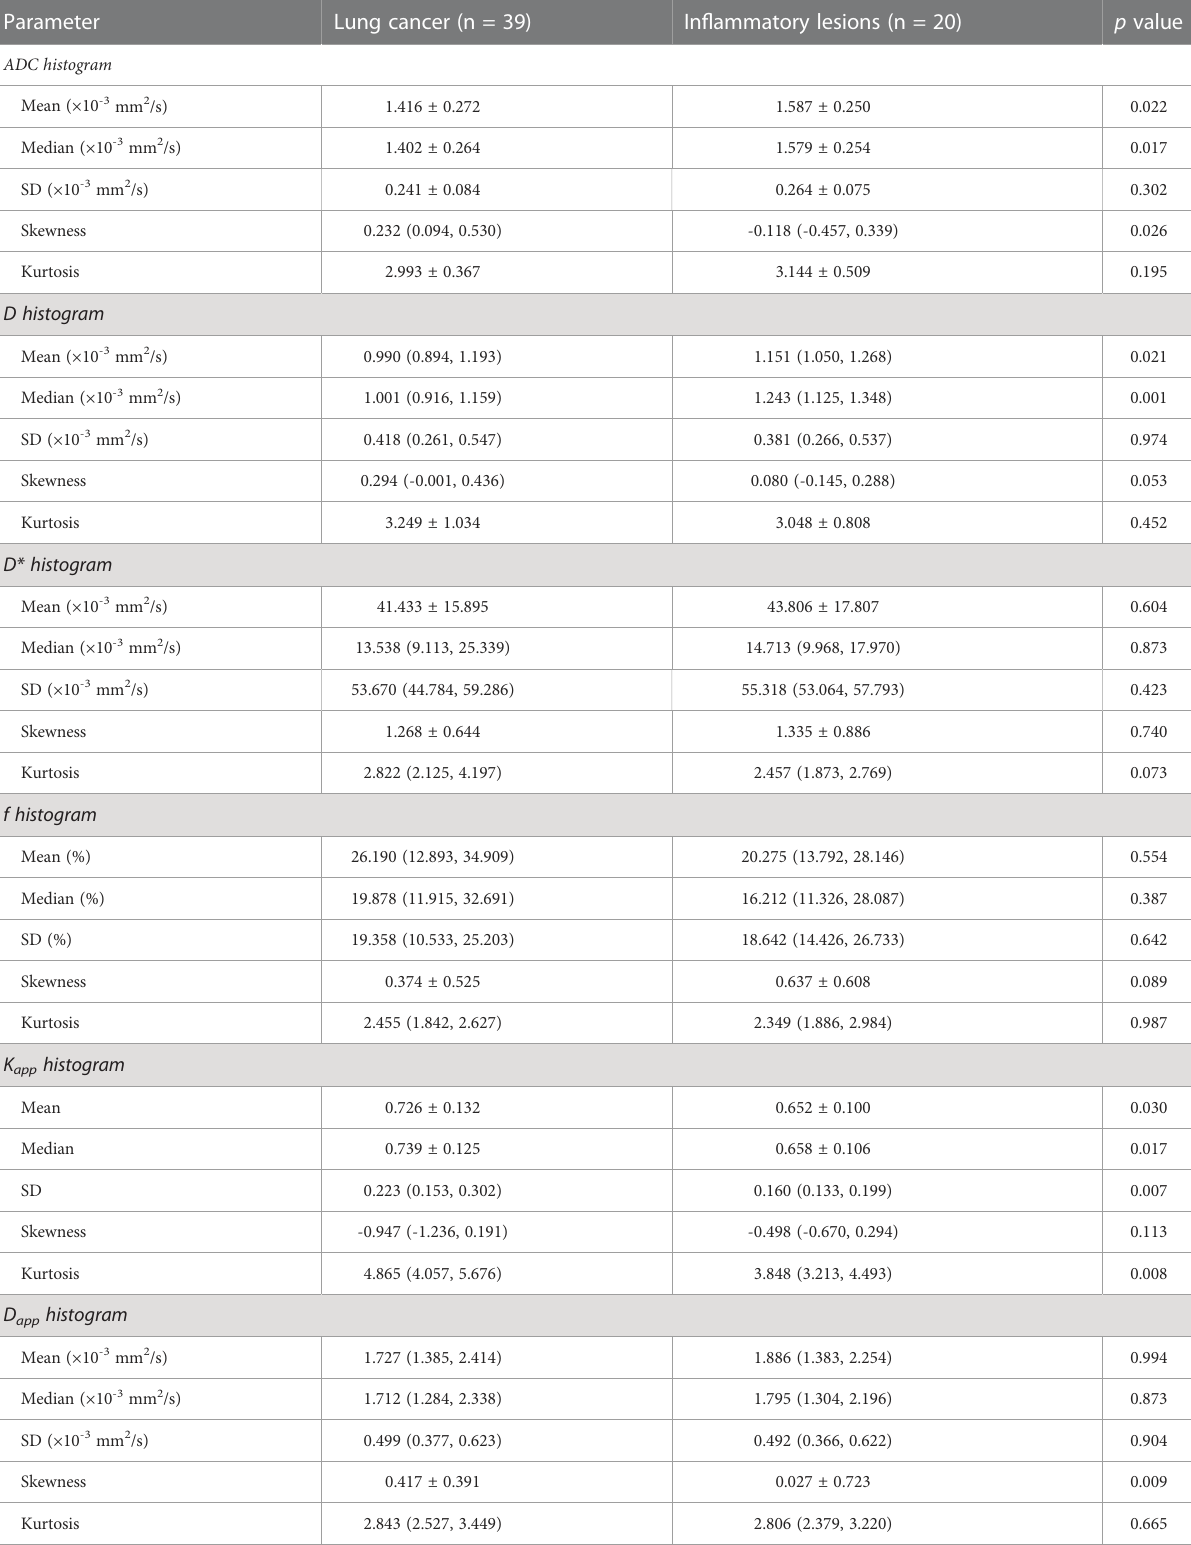
TABLE 4 Between-group differences in histogram